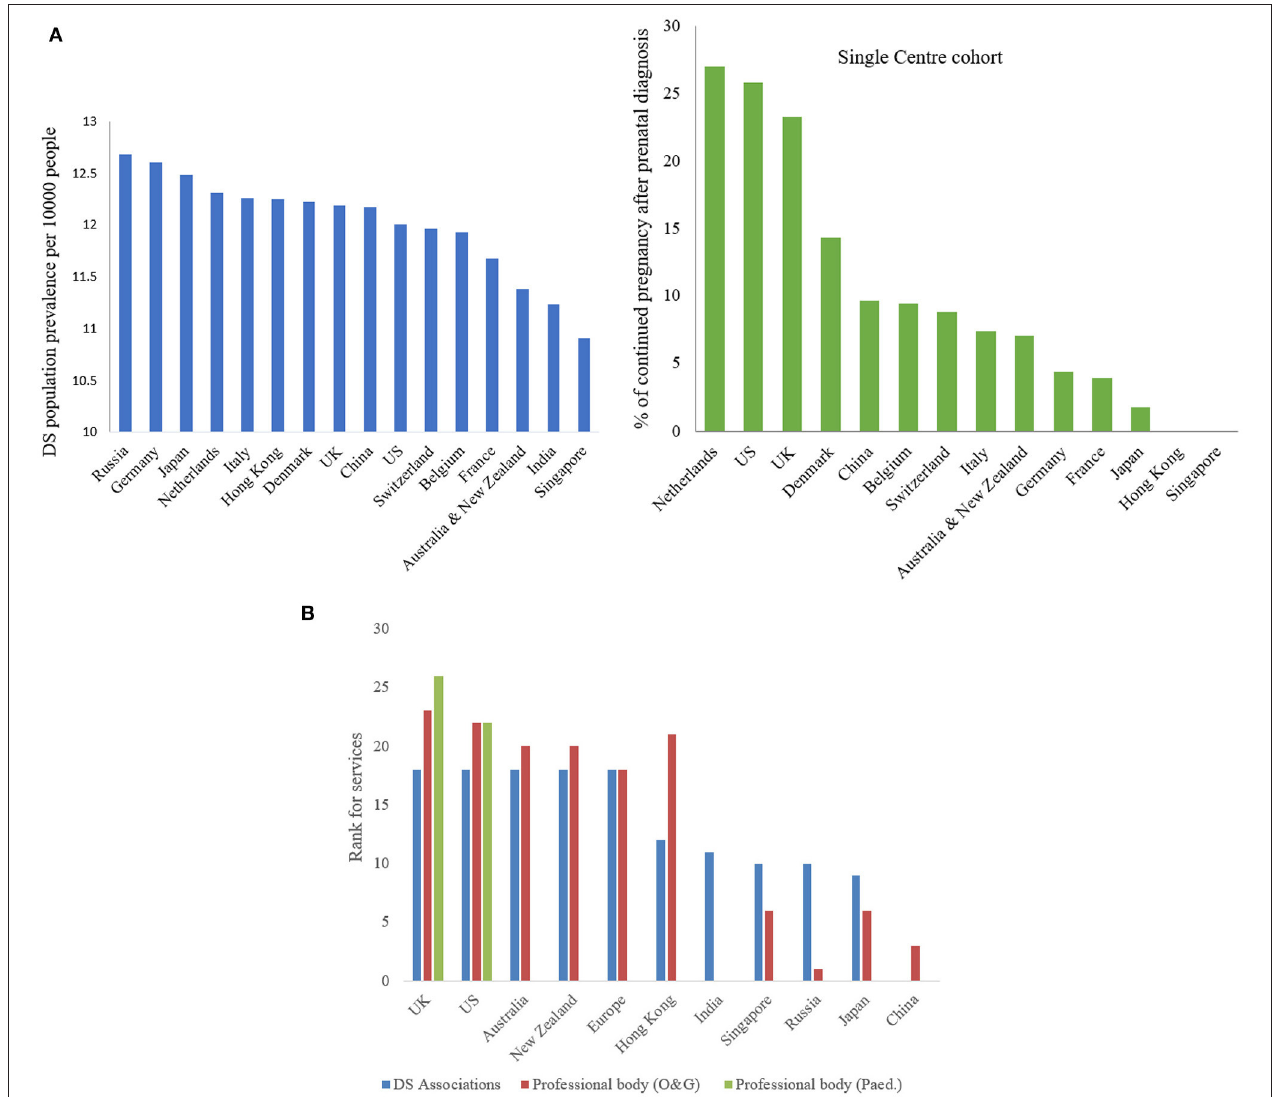
FIGURE 1 | (A) Down syndrome population prevalence (blue) and % of continued pregnancy after prenatal diagnosis (green). Demonstrating extrapolated prevalence of DS population per 10000 people in different countries, the highest in Russia (12.68) and the lowest in Singapore (10.91) and the highest percentage of continued pregnancy after prenatal diagnosis in Netherlands (27.03) and the lowest in Japan (1.85). (B) Ranking of services provided by DS associations and professional bodies (O&G and pediatric sector). Showing the services provided by DS associations (blue in color) and professional bodies for O&G sector (red in color) and pediatric sector (green in color), only UK & US providing services in all